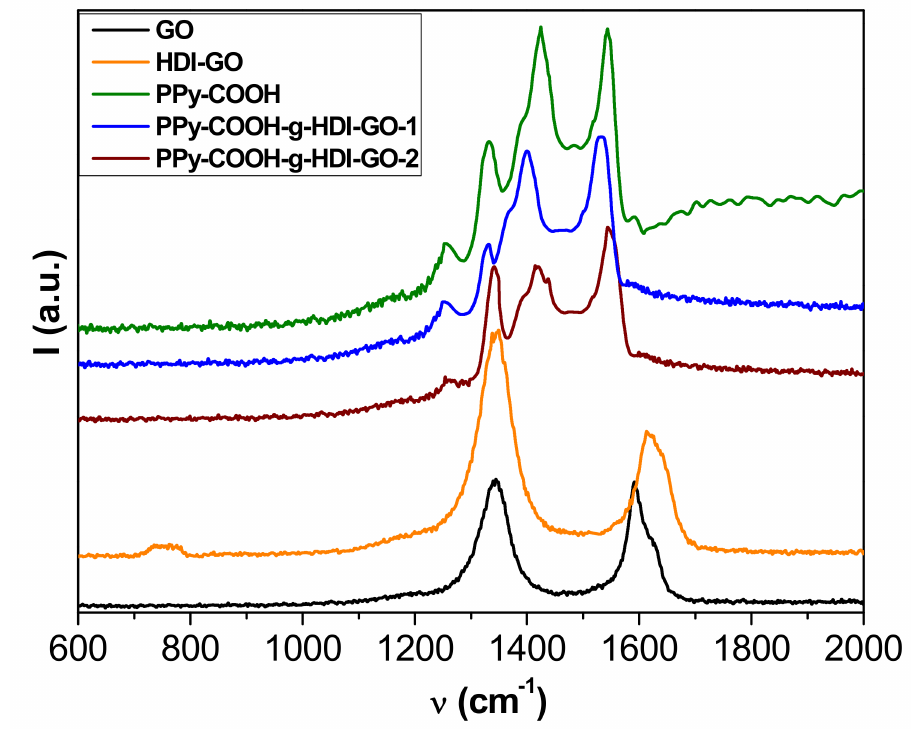
Figure 4. Raman spectra of GO, HDI-GO, PPy-COOH, PPy-COOH- g -HDI-GO-1, and PPy-COOH- g